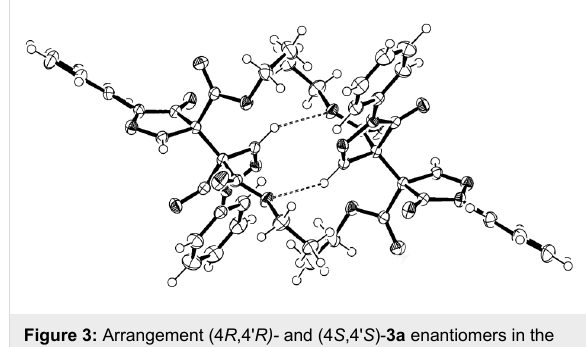
Figure 3: Arrangement (4 R ,4' R)- and (4 S ,4' S )- 3a enantiomers in the crystal unit drawn with 50% displacement ellipsoids. The hydrogen bonds are shown by dashed lines. Supplementary crystallographic data for compound 3a can be obtained free of charge from The Cambridge Crystallographic Data Centre via http:// www.ccdc.cam.ac.uk/data_request/cif (CCDC